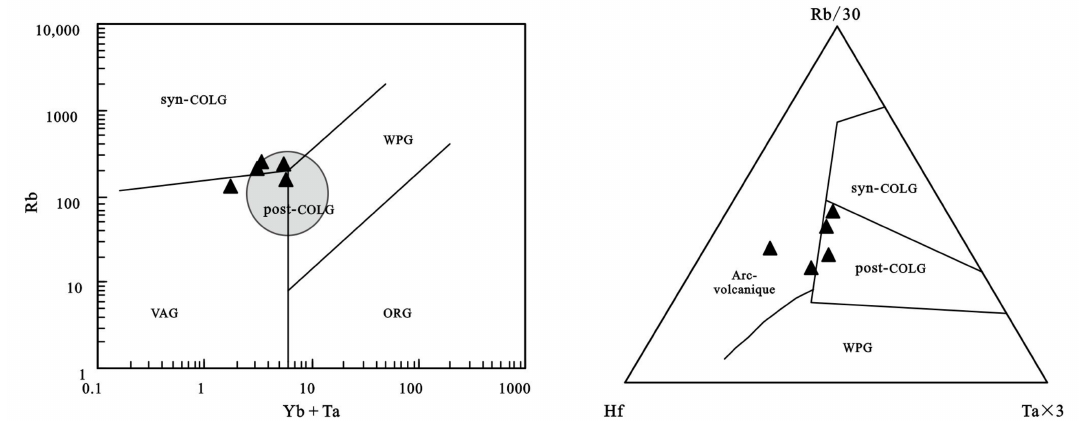
Figure 12. Discrimination diagram for tectonic settings of the biotite granite. (Rb–Yb + Ta diagram after peatce et al., [54]; Rb / 30–Hf–Ta × 3 after Harris et al., [55]). ORG—ocean ridge granites; post-COLG—post-collision granites; syn-COLG—syn-collision granites; VAG—volcanic arc granites; WOG—within plate